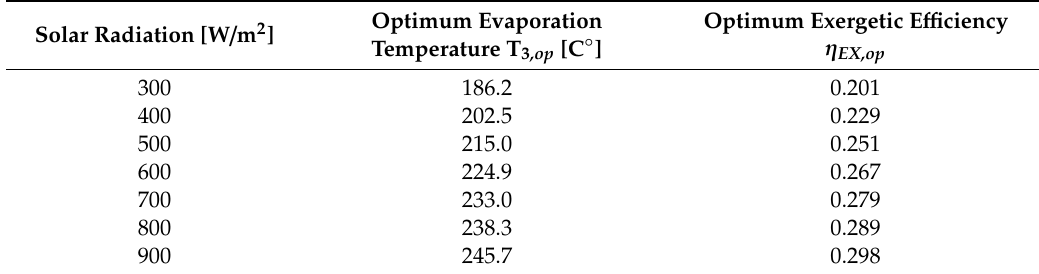
Table 2. Optimal evaporation temperatures and exergetic e ffi ciencies of the PTC-SRC system when condensation pressure is fixed at 1